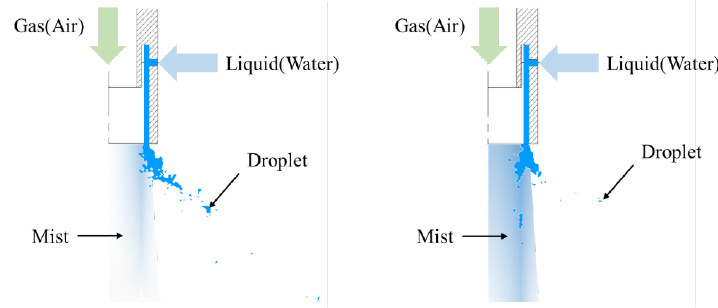
Figure 13. Sprays at low MFR ( left , 15) and high MFR ( right ,